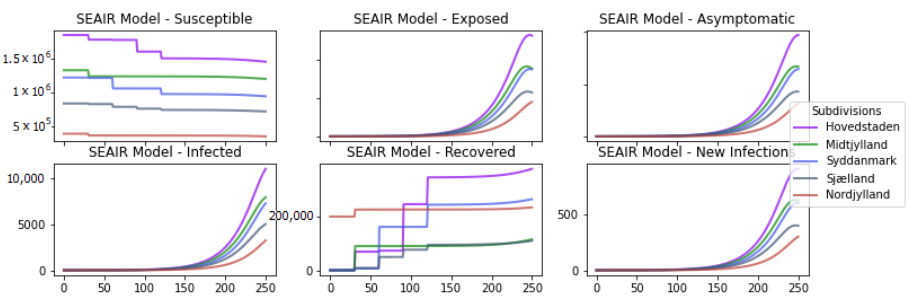
Figure 18. Plots of susceptible, exposed, asymptomatic, infected, recovered, and newly infected individuals per day for each region of the SEAIR model with the best vaccination plan found.